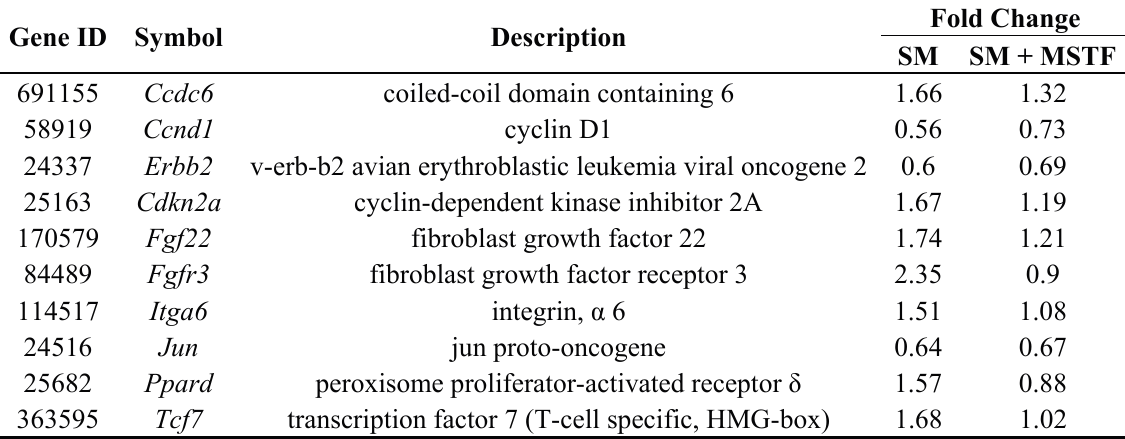
Table 3. List of 10 genes involved in pathways in cancer. These SM-induced alterations of expression were abolished or attenuated by MSTF treatment.